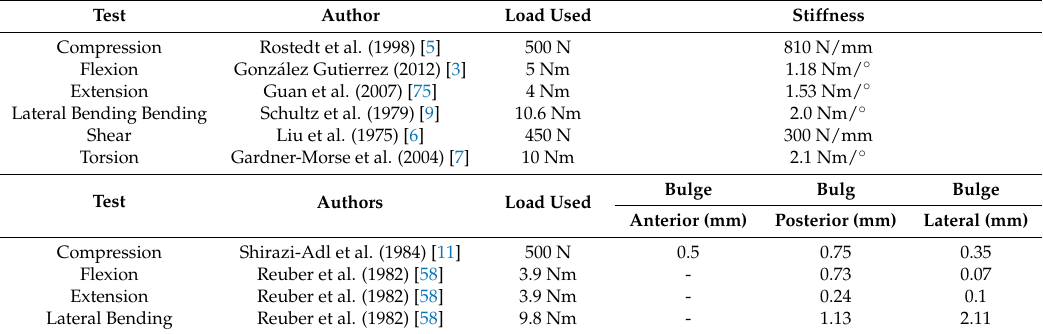
Table 6. Stiffness and bulge values selected from the standard tests that are used to adjust the parameters that define the behavior of the finite element (FE) model of the intervertebral lumbar disc.